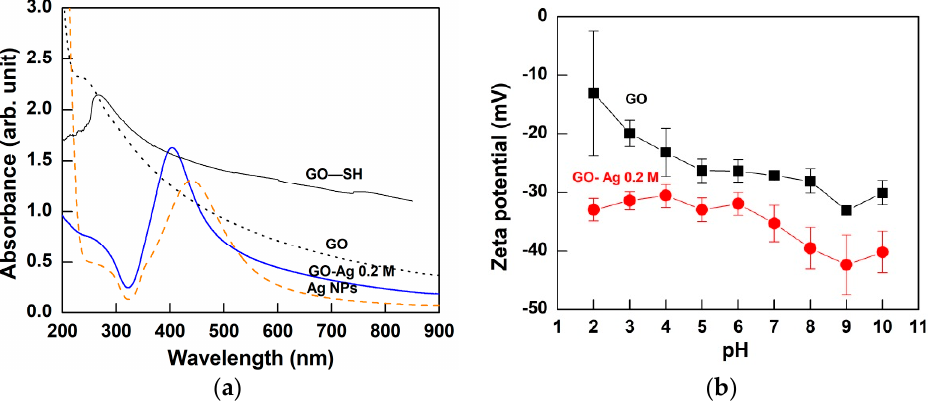
Figure 5. ( a ) UV-visible spectra of pristine GO, pristine Ag nanoparticles, GO–SH, and GO-Ag 0.2 M composite; ( b ) zeta potential profiles of pristine GO and GO-Ag 0.2 M composite.